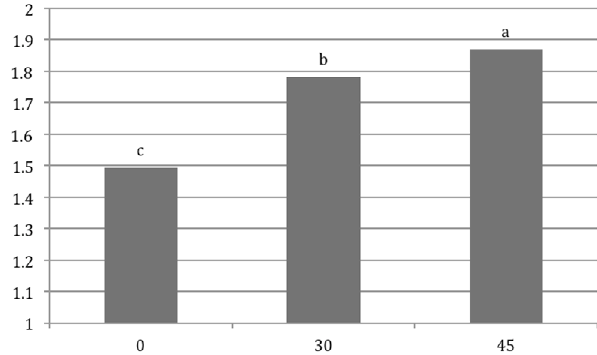
Fig. 4. Pulsed electromagnetic field effect on yield (g per plant) of two durum wheat varieties. Seeds have been treated for 0 (control), 30 and 45 minutes with magnetic field